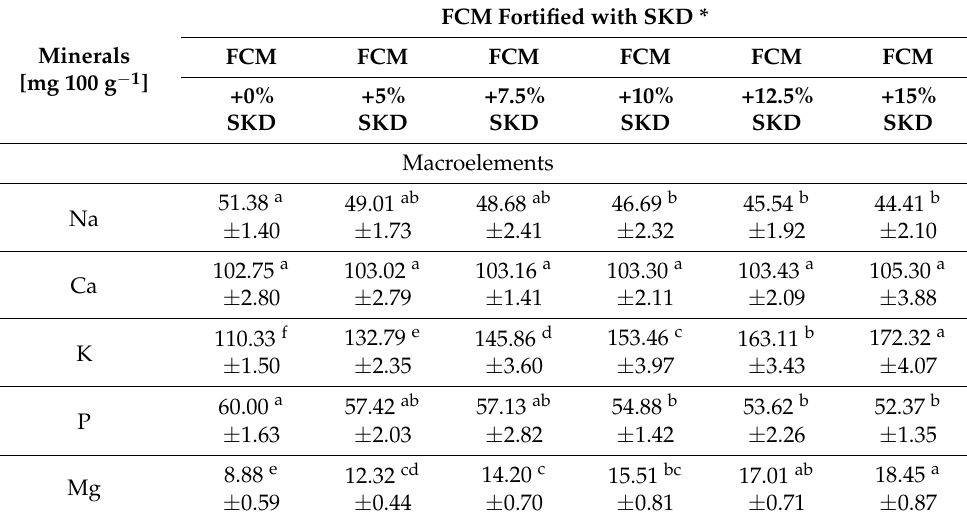
Table 3. Mineral contents (mg 100 g − 1 ) of fermented camel milk (FCM) and FCM fortified